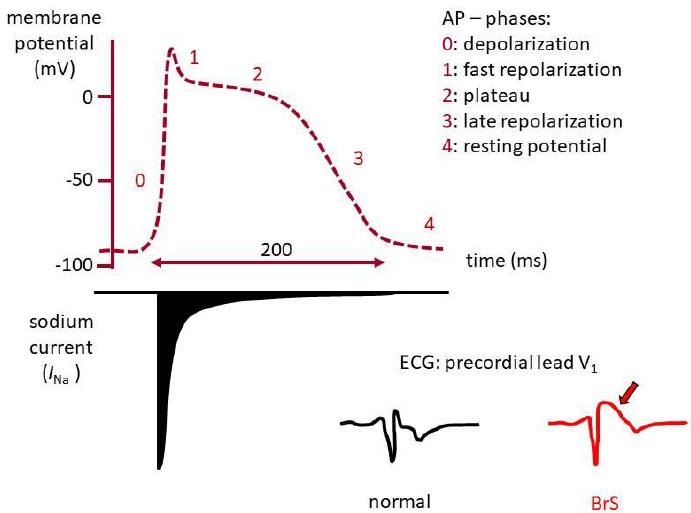
Figure 1. Role of Na V 1.5 in the generation of the cardiac action potential (AP). Schematic representation of the cardiac AP and the contribution of the sodium current (I Na ) generated by Na V 1.5 as responsible for the rising (depolarization) phase. The electrical pattern of precordial lead V1 of a normal electrocardiogram (ECG) and one with an ST segment elevation typical of BrS are shown (arrow).